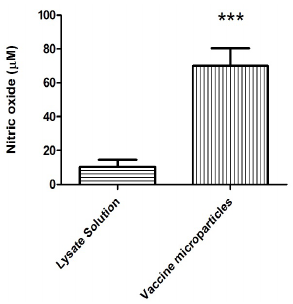
Figure 4. Nitric oxide released by 300,000 DCs (DC 2.4) following incubation with lysate (vaccine) solution and 300 µg of vaccine-loaded microparticles. Vaccine-loaded microparticles induced a higher nitric oxide release compared with lysate solution. (*** p < 0.001).